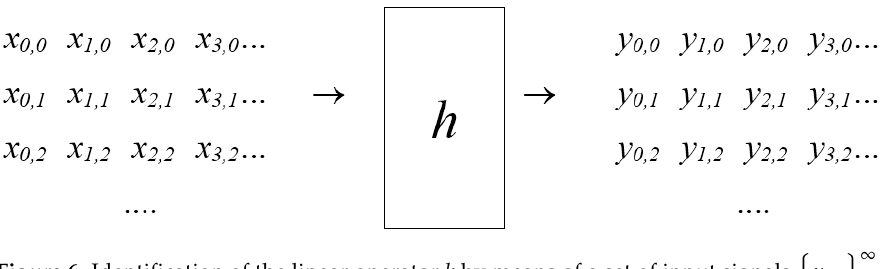
Figure 6. Identification of the linear operator h by means of a set of input signals } The matrix elements of the operator h lay on diagonal and sub-diagonals, which results from the causality condition, and are determined from the set of linear equations. From the formula